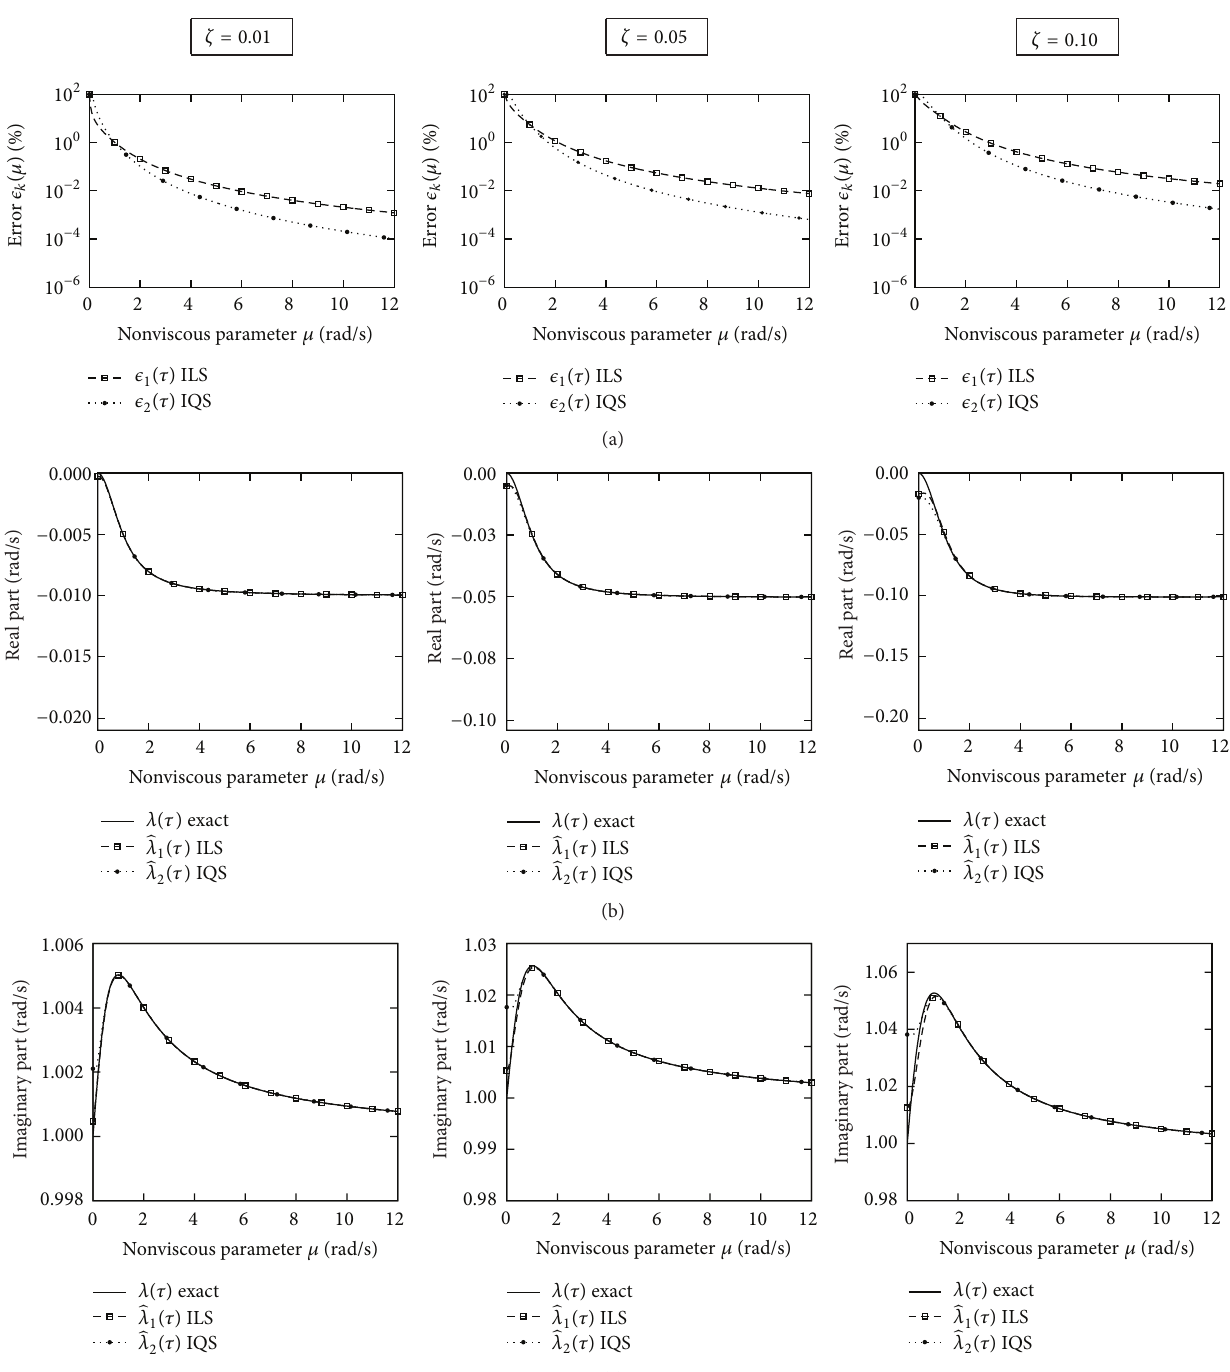
Figure 4: Case 𝜃 = 𝜏 = 1/𝜇 . Relative error 𝜖 𝑘 (𝜏) = |Ψ − 𝜓 𝑘 |/|Ψ| of the integrand function (a). Eigenvalues versus parameter 𝜇 (b and c). Continuous line for exact values and dotted one for Improved Solutions: square tick for Linear (ILS) and bullet for Quadratic (IQS).